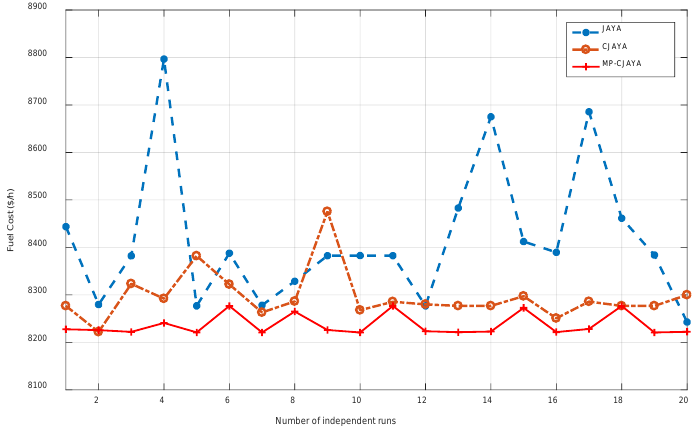
P = 850 MW). Figure 3. Fuel cost for 20 independent runs of 3-units system ( P D = 850 D P = 850 MW). D